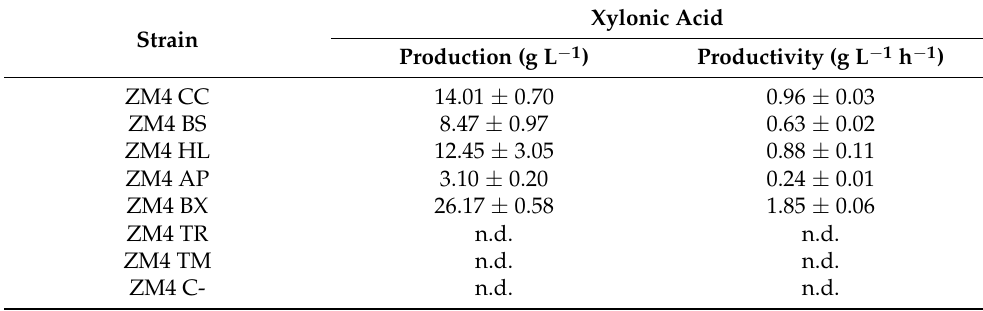
Table 2. Production and productivity achieved by Z. mobilis strains overexpressing different XDH